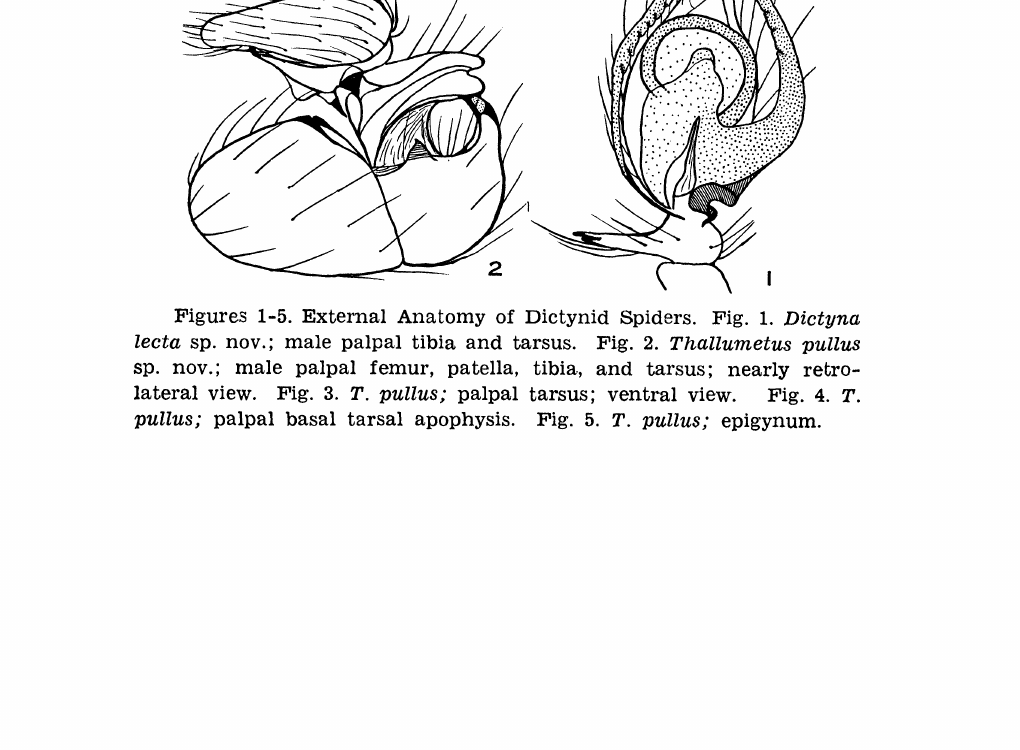
pulIus; palpal basal tarsal apophysis. Fig. 5. T. pullus;